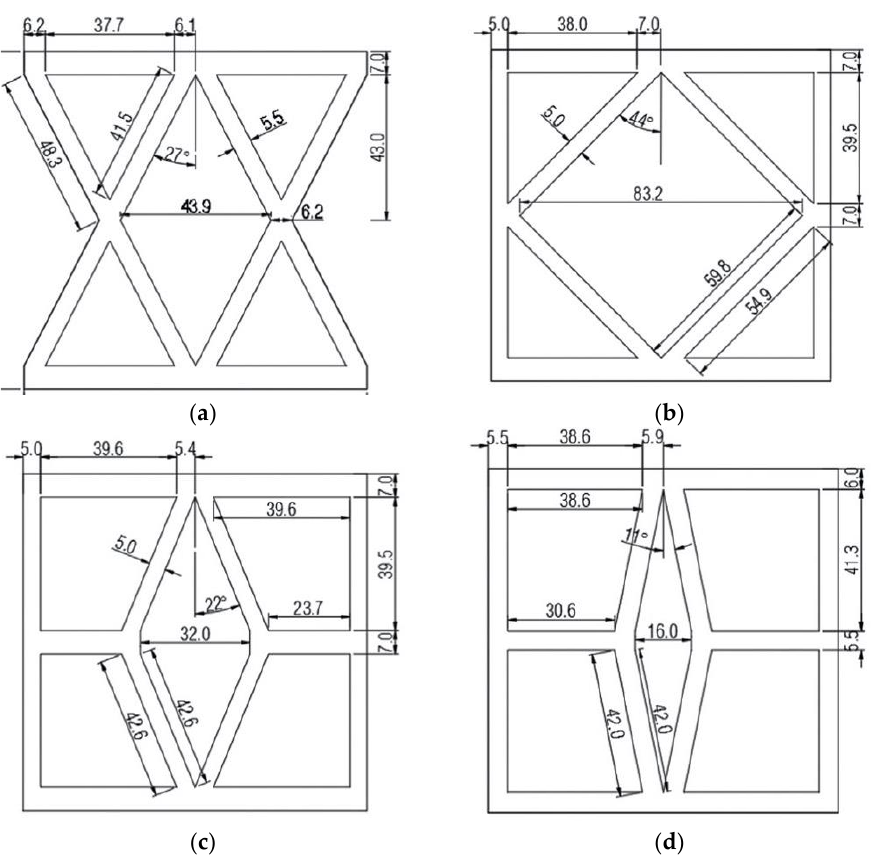
Figure 1. ( a – d ) Novel cross-section shapes (optimised). All cross-sections are 100 mm × 100 mm.